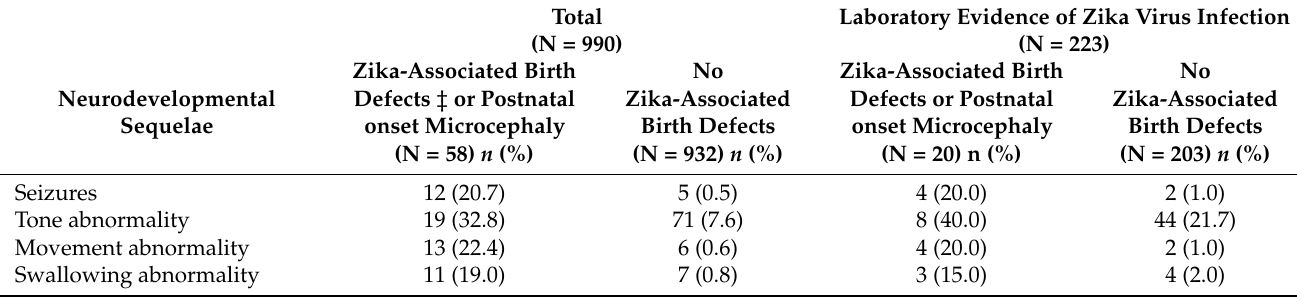
Table 4. Early childhood neurodevelopmental outcomes * among children with follow-up data born to pregnant women with symptoms of Zika virus disease and subset with laboratory evidence † of Zika virus infection, Project Vigilancia de Embarazadas con Zika (VEZ), Colombia,